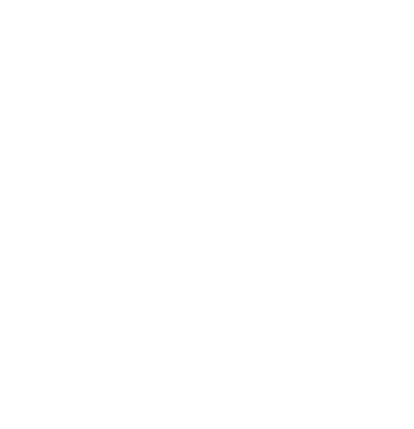
Figure 1. Schematic view of the THz time-domain spectroscopy system employed in the experiments.